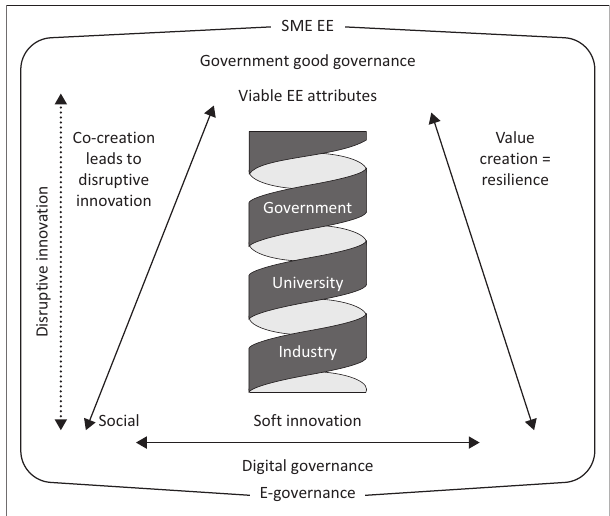
FIGURE 3: Conceptual framework for an innovation-led entrepreneurial